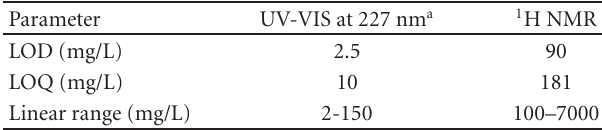
Figure 3: 1 H NMR spectra of DMSO extract of surrogate alcohol (a) and DEP standard (b). Table 2: Comparison of method validation results for DEP.